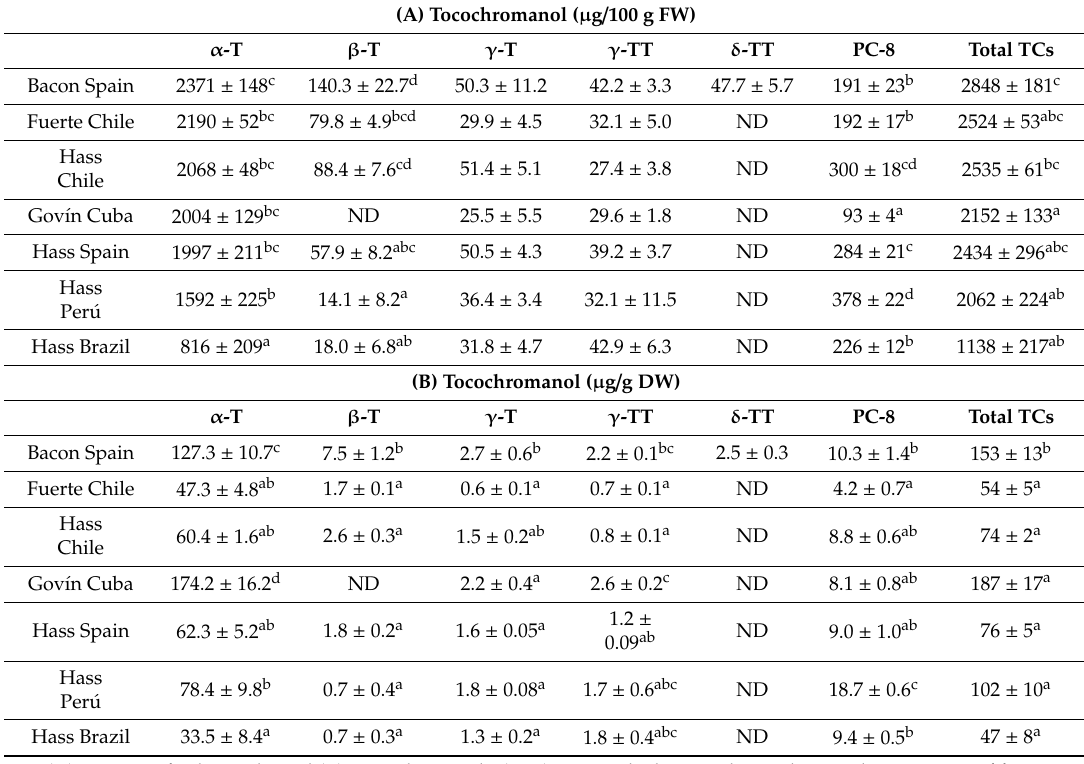
Table 1. Contents of tocochromanols in di ff erent avocado varieties, including various